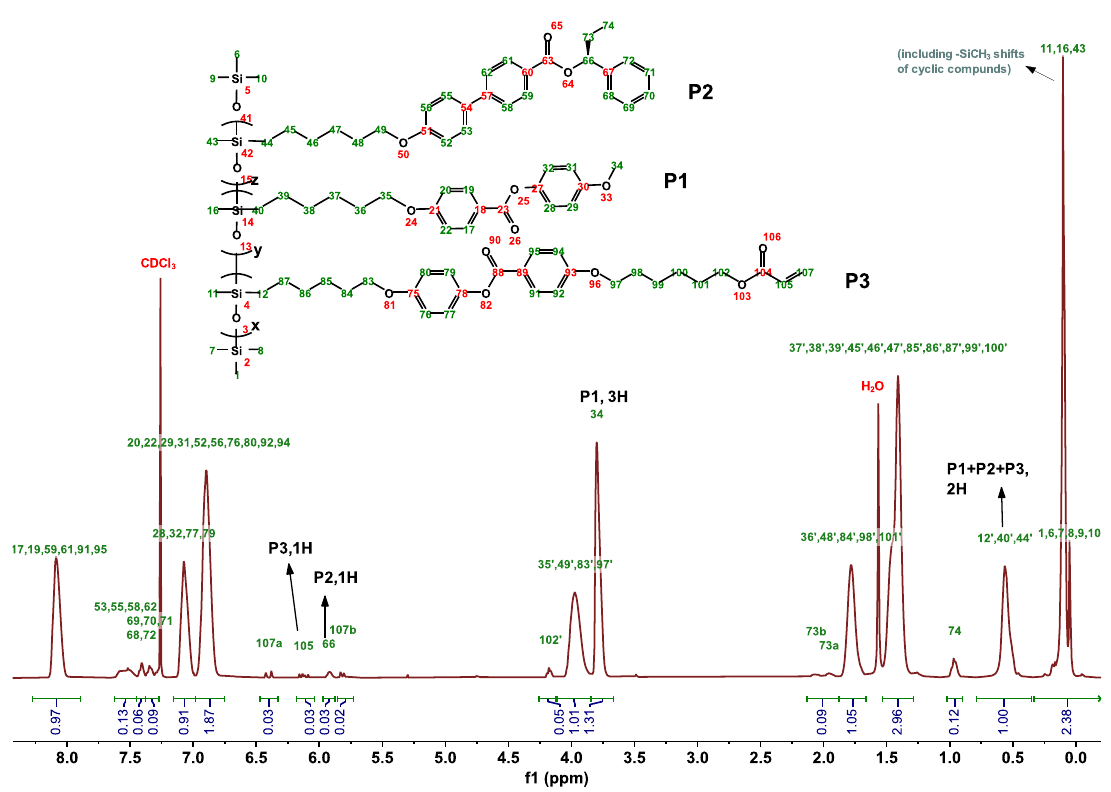
Figure 1. 1 H NMR spectrum of TP, with peak assignments and peak integral values.